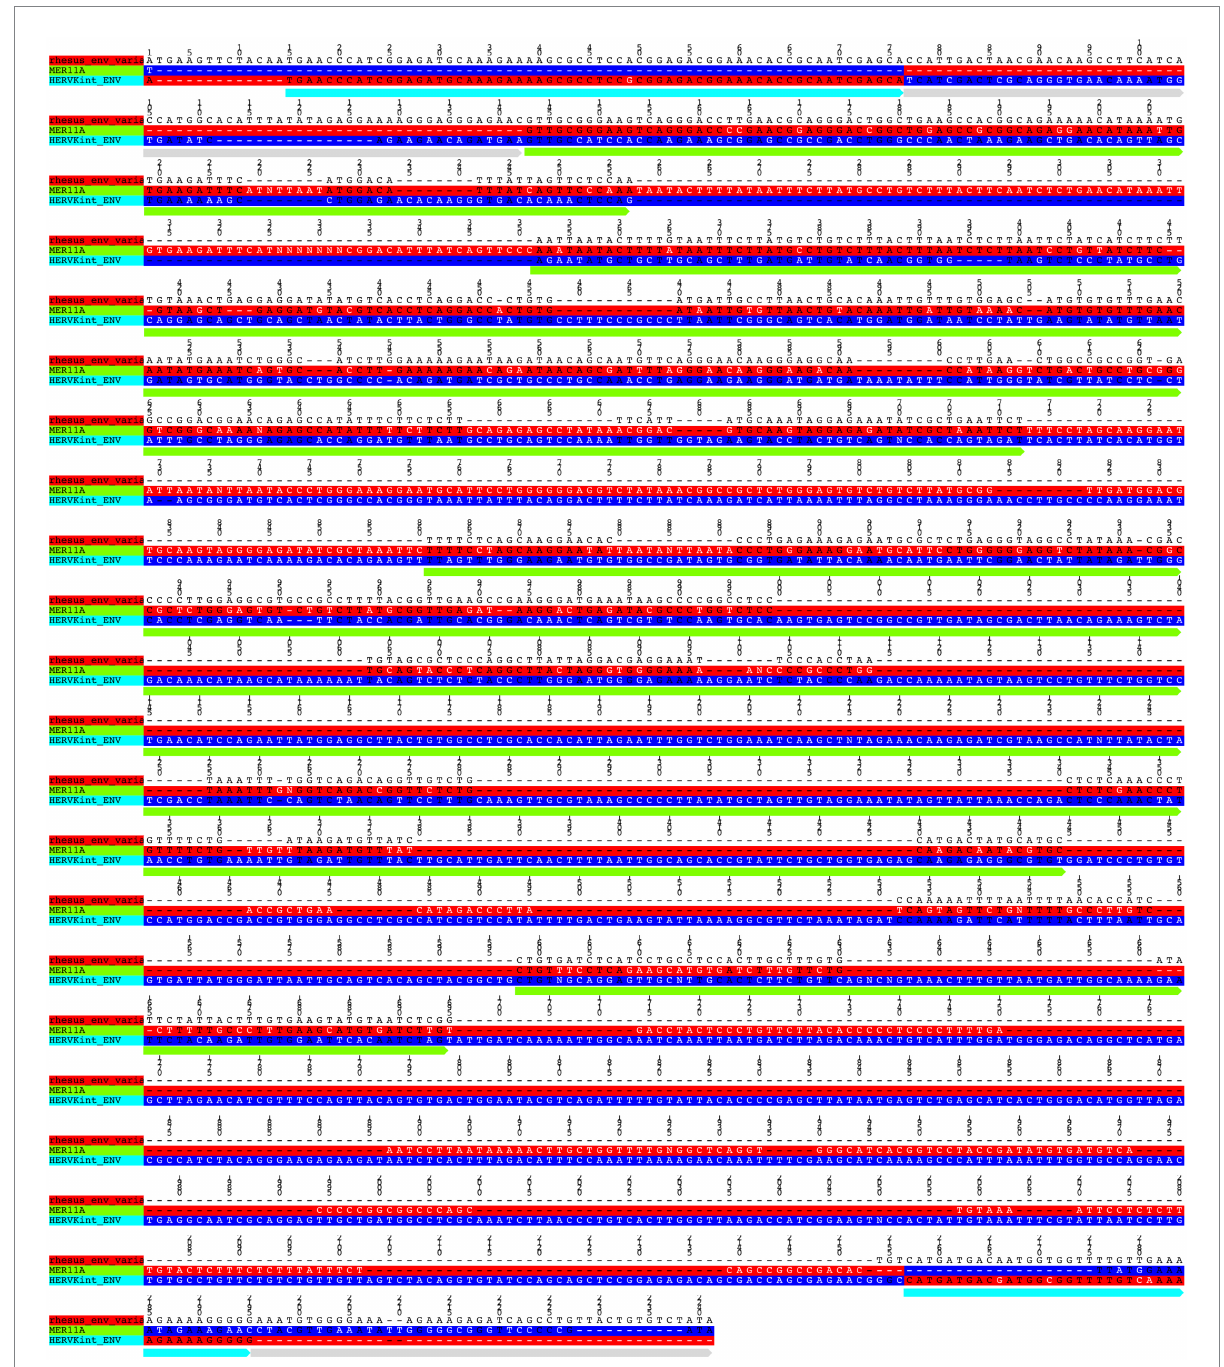
FIGURE 8 Test of recombination between macaque HML2 env variant3 and HML8 MER11A LTR The portions deriving from HML2 env gene (cyan) and MER11A LTR (green) are annotated along rhesus consensus for env